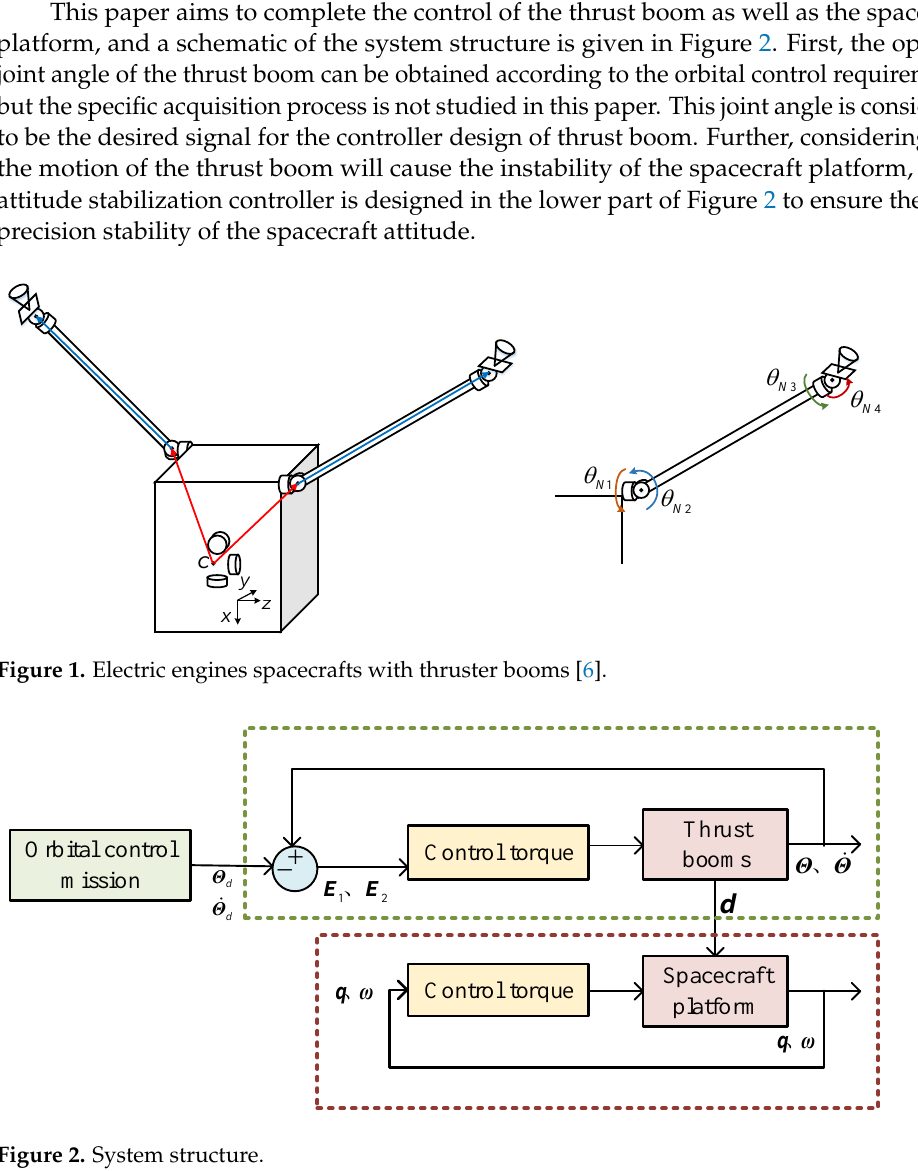
Figure 2. System